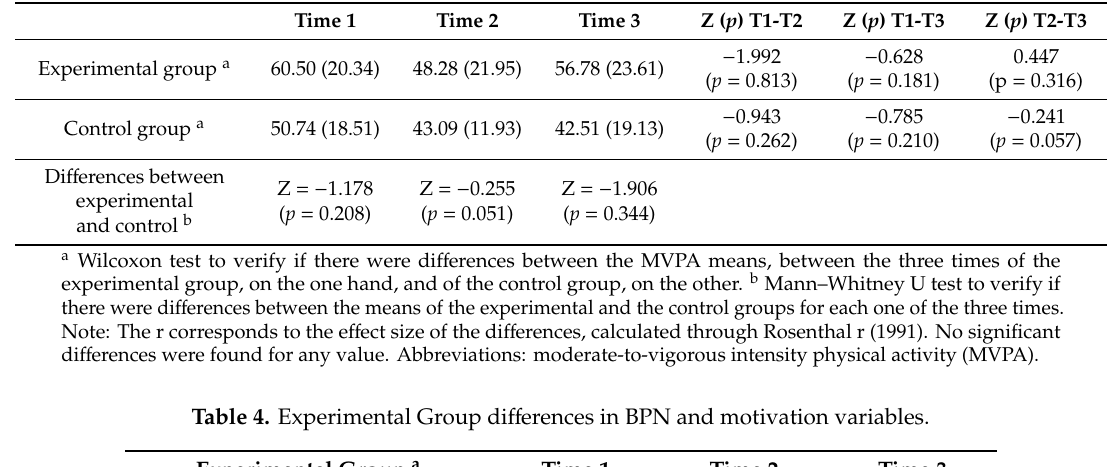
Table 3. Intra- and inter-di ff erences in MVPA in Times 1, 2, and 3.